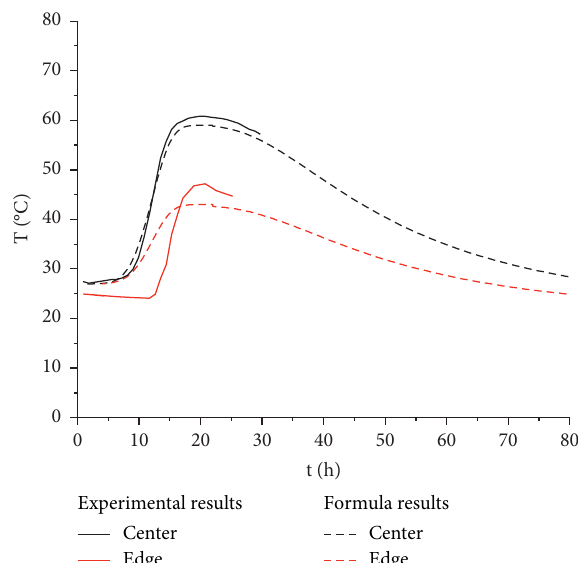
Figure 16: Comparison of formula-calculated results with the experimental results from Sun et al. [18].